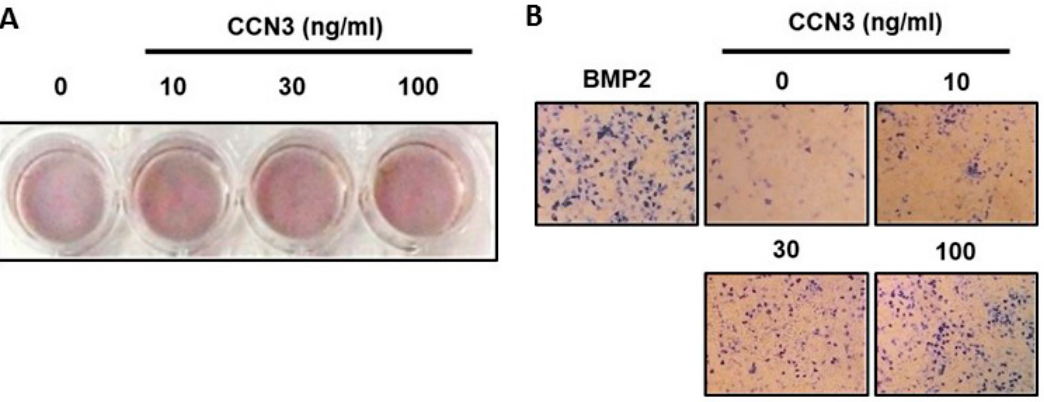
Figure 1. CCN3 enhances osteoblast differentiation. Osteoblasts were plated in 24-well plates and cultured in a medium containing vitamin C (50 µ g / mL) and β -glycerophosphate (10 mM) for 2 weeks ( A ) or 2 days ( B ). The cells were also treated with CCN3. At the end of the experiment, the cultures were fixed and assessed by alizarin red-S ( A ) and alkaline phosphatase (ALP) staining ( B ). 2.2. CCN3 Enhances Runx2 and Osterix Expression in Osteoblasts